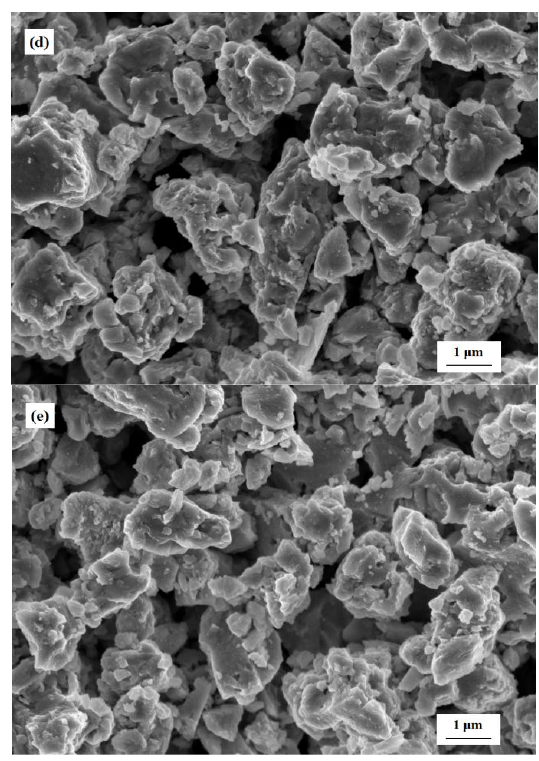
Figure 9. SEM images of the surfaces of the gas sensors: ( a ) S(c); ( b ) S(m); ( c ) S(c/m1); ( d ) S(c/m2); and ( e ) S(c/m3).